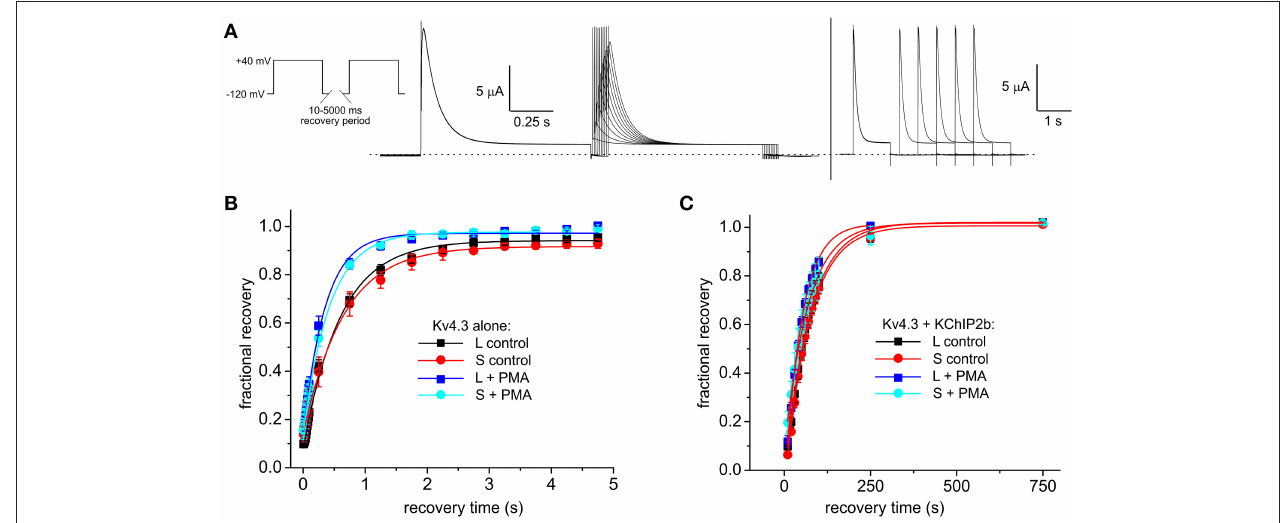
FIGURE 5 | KChIP2b regulates the effects of PKC stimulation on Kv4.3 inactivation recovery. (A) Exemplar current traces recorded using short (left) and long (right) inactivation recovery protocols (left inset), from a Xenopus oocyte expressing Kv4.3L and KChIP2b. (B) Mean ± SEM fractional current recovery plotted from traces recorded as in (A) for homomeric Kv4.3L or Kv4.3S in normal bath solution (control) or after 15 min in bath solution containing 50 nM PMA; n = 4–5. (C) Mean ± SEM fractional current recovery plotted from traces recorded as in (A) for Kv4.3L ( n = 11–12) or Kv4.3S ( n = 5–10) with KChIP2b in normal bath solution (control) or after 15 min in bath solution containing 50 nM